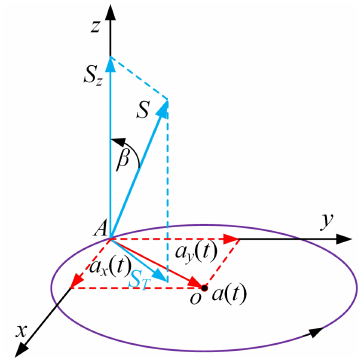
Figure 2. The principle of testing transverse